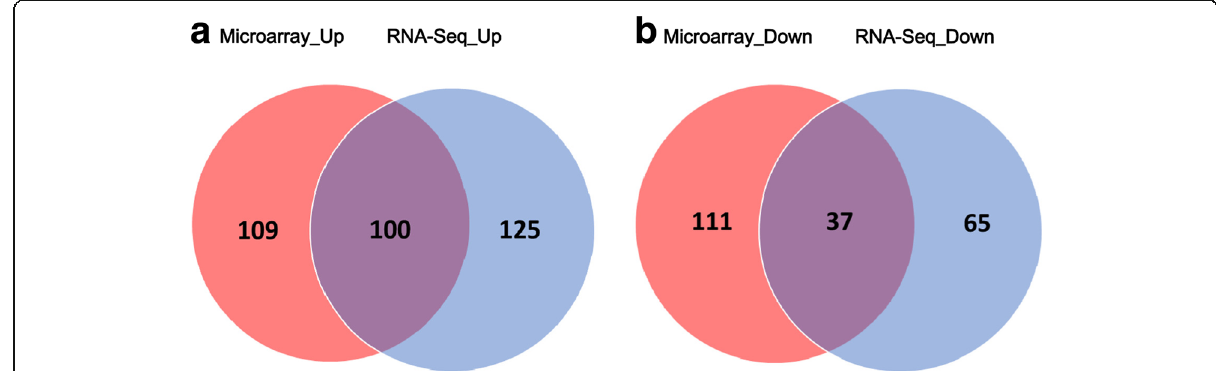
Fig. 4 Overlap of differentially expressed genes between rice microarray and RNA-Seq data. (A) Overlap of up-regulated genes between rice microarray and RNA-Seq data. (B) Overlap of down-regulated genes between rice microarray and RNA-Seq